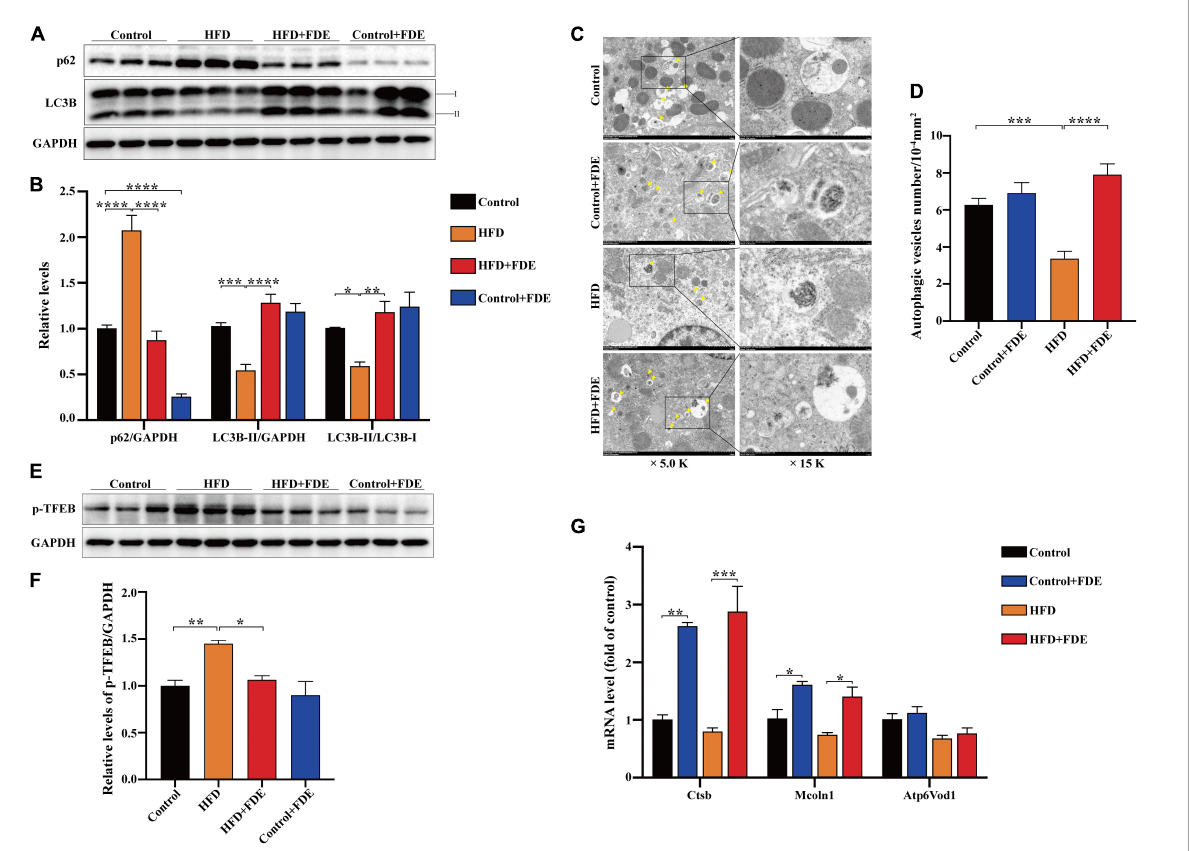
FIGURE4 Fagopyrum dibotrys extract supplementation induces autophagy in the livers of mice with HFD-induced NAFLD. (A,B) Protein expression of P62 and LC3B, as detected by Western blot. (C) Representative transmission electron microscopy (TEM) images of autophagic vacuoles in hepatocytes (magnification × 5,000 or × 15,000; scale bar, 2.0 or 1.0 µ m). The arrows indicate the autophagosome or autophagic vacuole. (D) Autophagic vesicles (arrow) were quantified in each group. (E,F) Protein expression of p-TFEB, as detected by Western blot. (G) Relative mRNA levels of TFEB target genes. The data were analyzed by one-way ANOVA. All values are presented as the means ± SEM, and n = 3–6 per group. Control, normal diet; HFD, high-fat diet; Control + FDE, a mixture of FDE and normal diet; HFD + FDE, a mixture of FDE and high-fat diet. * P < 0.05, ** P < 0.01, *** P < 0.001, **** P < 0.0001. HFD group versus the control group, HFD + FDE group versus the HFD group, or control + FDE group versus the control